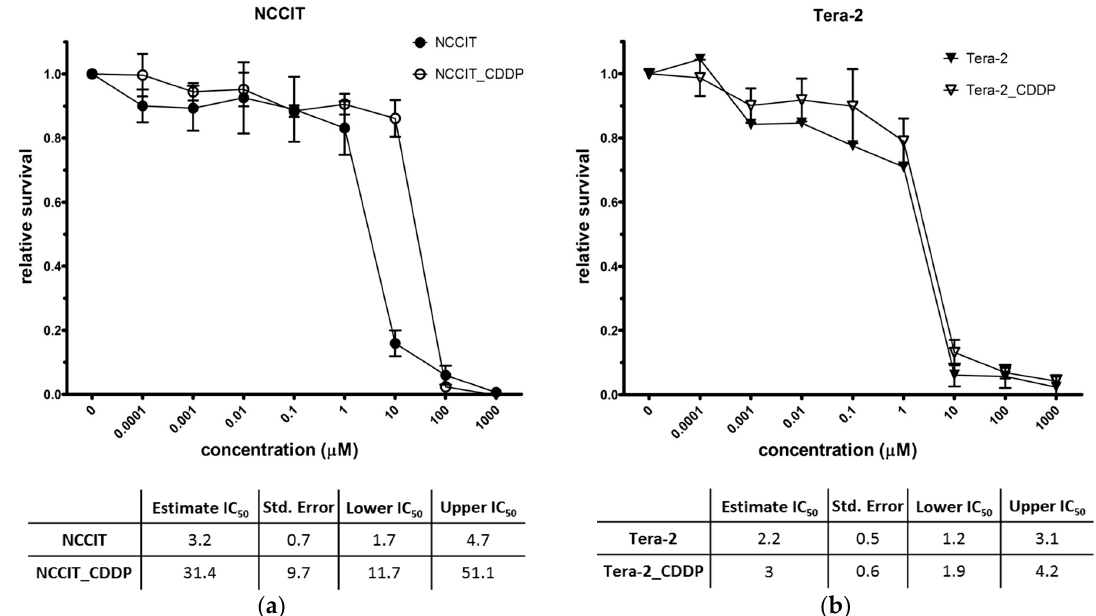
Figure 1. Final sensitivity of TGCTs cell lines to CDDP measured by MTS assays after 72 h of CDDP treatment: ( a ) CDDP-naive (NCCIT) and CDDP-treated (NCCIT_CDDP) NCCIT cell lines; ( b ) CDDP-